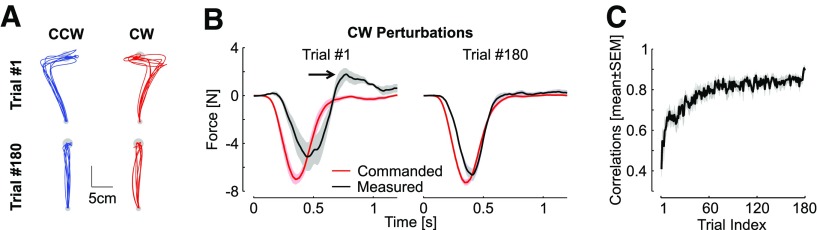
Control experiment, data from Crevecoeur et al. (2020). A, Individual hand traces from the first and last perturbation trials in each direction from the control experiment (one traces per participant, n = 8). B, Commanded (black) and measured (red) force profiles for the first (left) and last (right) clockwise perturbations. The arrow highlights the increase in peak terminal force linked with the target overshoot. Observe that the traces become very similar, which increases the temporal correlation between them. C, Correlations between commanded force and measured force as in Figure 3 against trial indices. Correlations were averaged across directions and participants. Displays are mean ± SEM across participants.